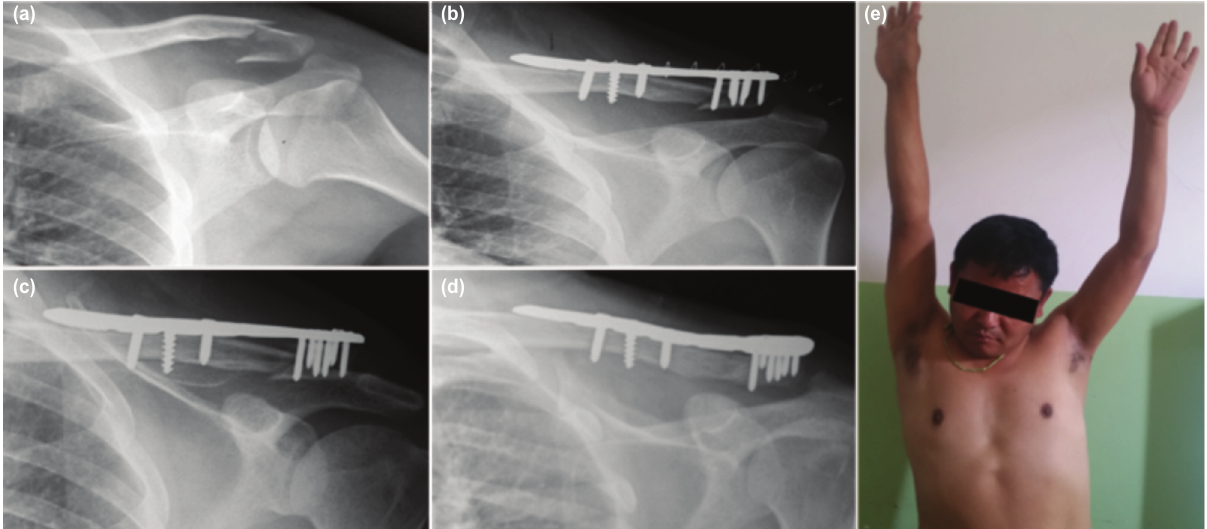
(a) Antero-posterior radiograph of shoulder joint showing comminuted lateral third clavicle fractures, (b) Immediate post- Fig. 2: operative radiograph after fixation with pre-contoured lateral third clavicular plate, (c) Radiograph of clavicle 6 weeks after surgery, (d) Radiograph of clavicle 20 degrees caudal AP view 5 months after surgery showing bony union and (e) Abduction of shoulder joint 6 weeks after surgery.